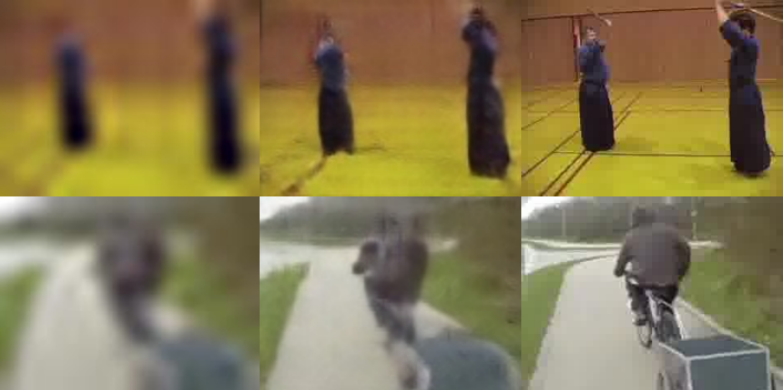
Figure 7. Visualization of some corresponding low-, super-, and high-resolution images of HMDB51. The left column shows low-resolution images; the middle column shows super-resolved images; the right column shows high-resolution